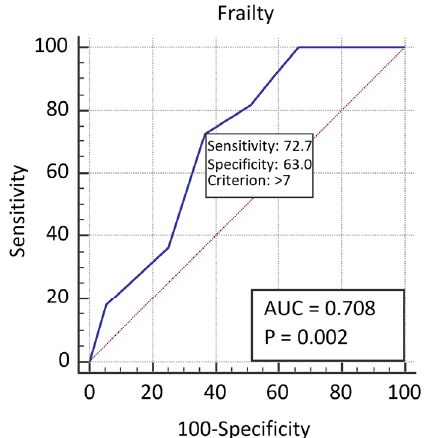
Figure 1. The ROC curves for the prediction of an electric shock of an ICD by frailty.